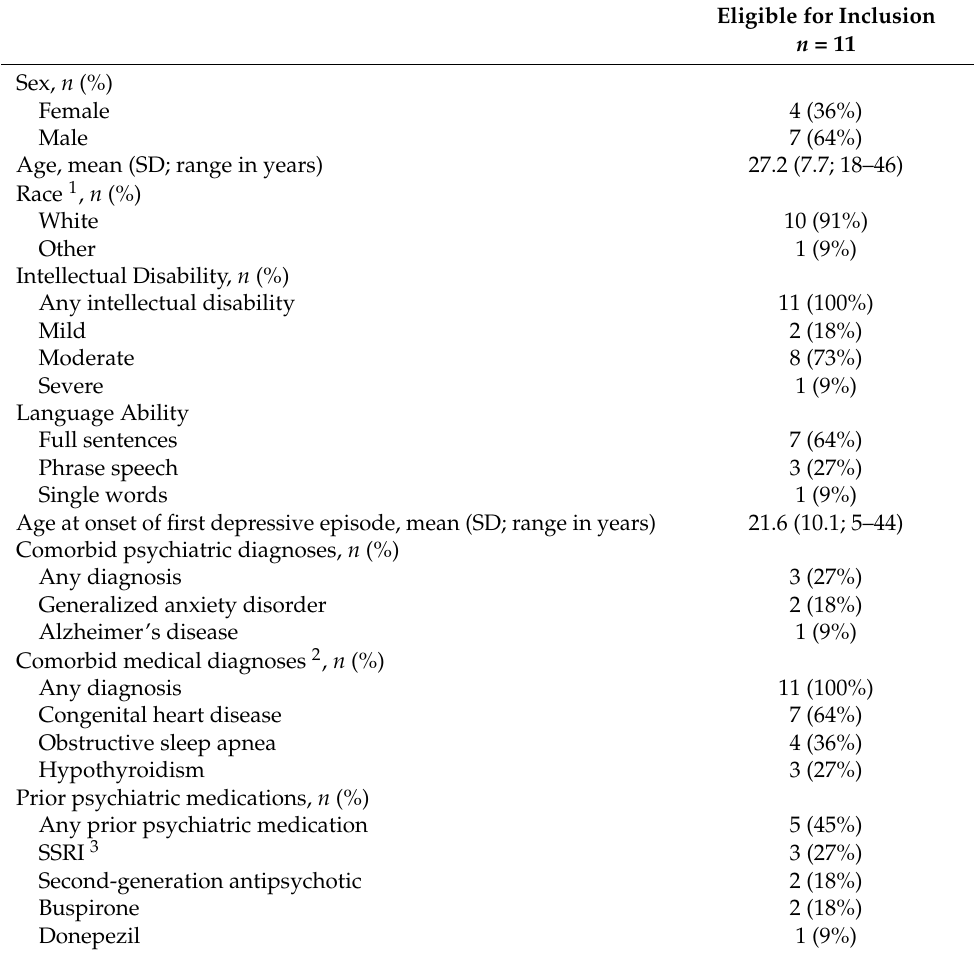
Table 1. Demographic and Clinical Characteristics of Patients at the Time of SSRI